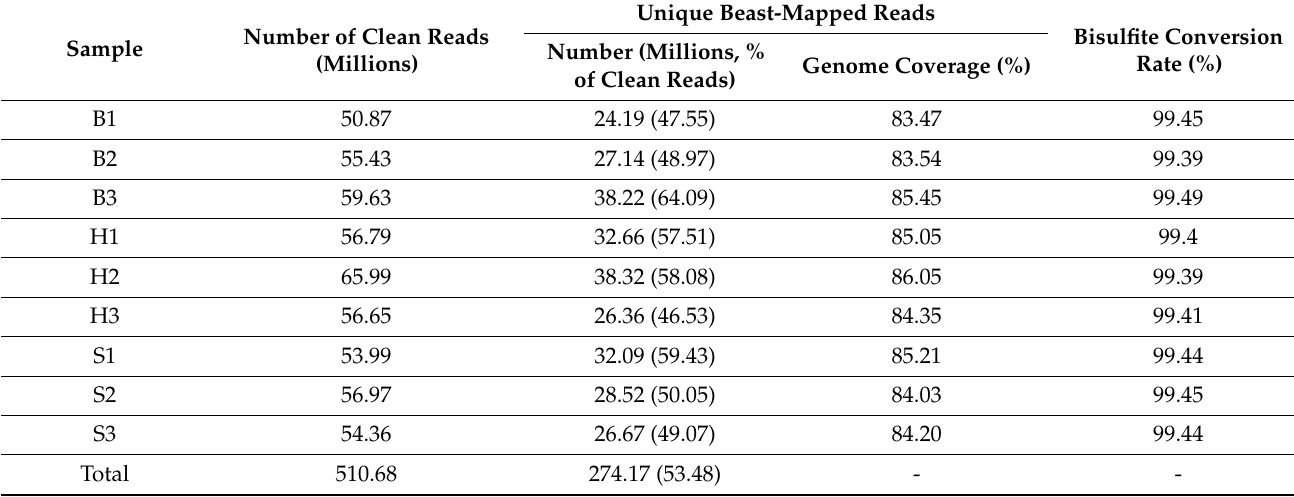
Table 1. Summary of the whole-genome bisulfite sequencing data of holdfast (H), stipe (S) and blade (B) in Saccharina japonica .